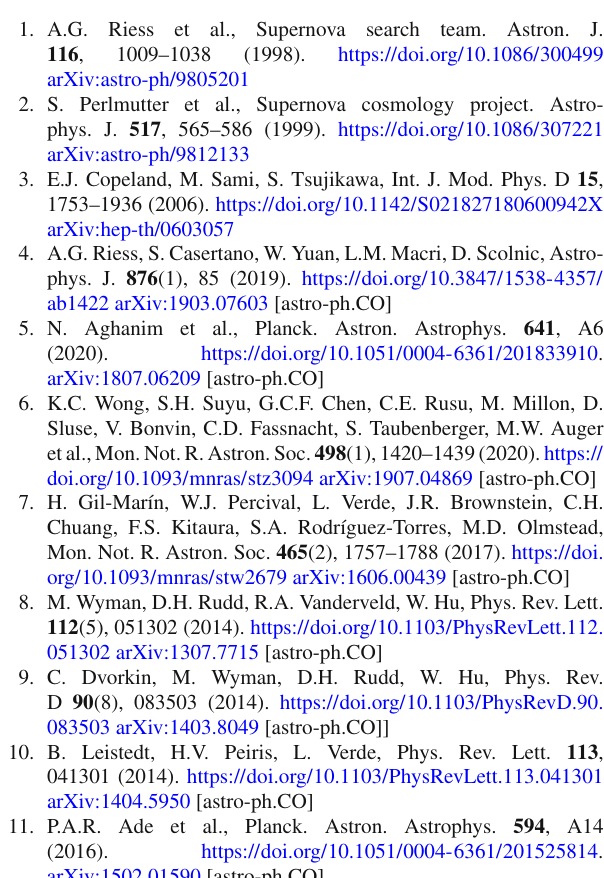
The AIC analysis with different datasets also confirms this result. Finally, we compared the eADE model with (cid:2) CDM in the CMB and the matter power spectra. The observational data points prefer our eADE model to (cid:2) CDM at a small scale structure but are hard to distinguish in present